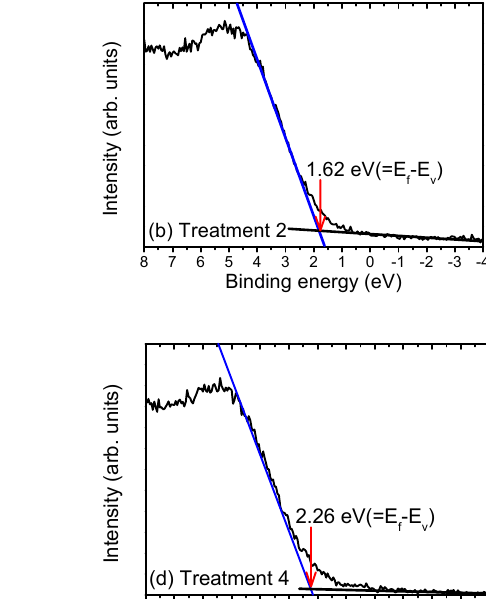
Treatment 1 Figure 4. Ratio of Ga–O/Ga–N obtained using the XPS spectra from the Ga3d core levels of the GaN layer. Figure 5 shows the XPS valence band spectra of GaN treated with various treatments. A binding energy of 0 eV on the horizontal axis corresponded to the energy position of the Fermi level ( E f ) at the surface. The energy position of the valence band maximum (VBM) was determined by linearly